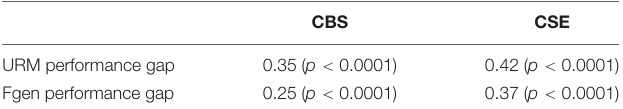
TABLE 5 | URM and first-generation (Fgen) performance gaps in total grade across the College of Biological Sciences (CBS) and the College of Science & Engineering (CSE) measured by standard deviations from class